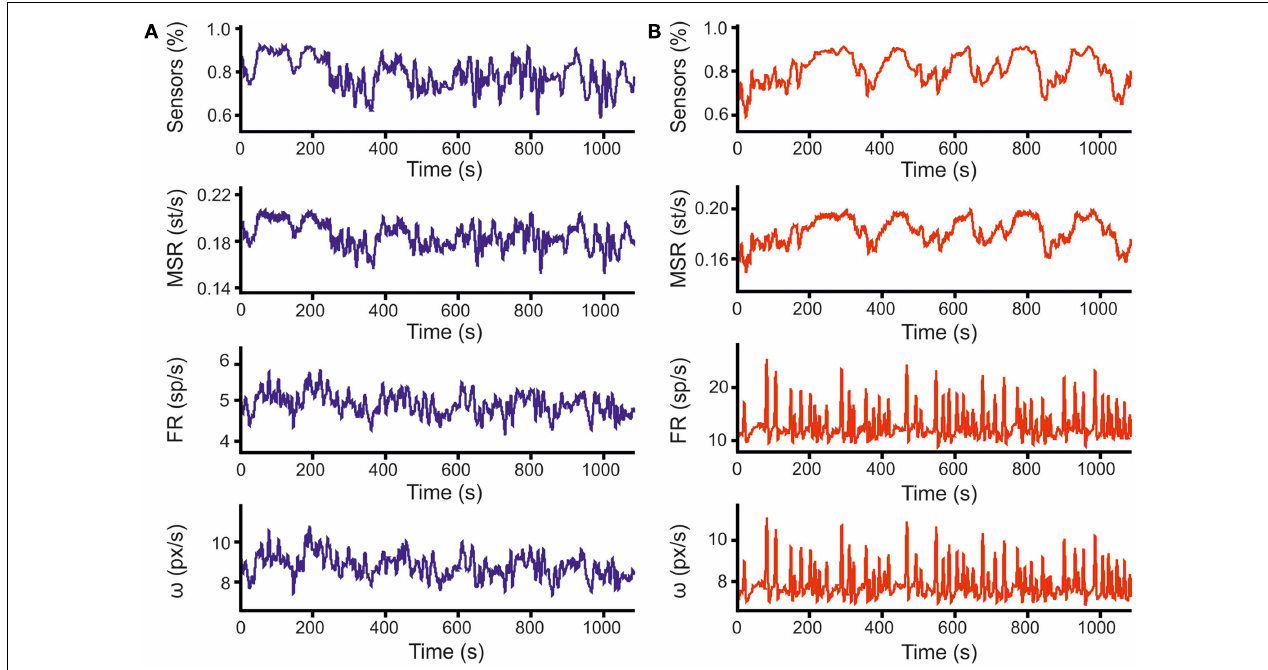
the robot wheels, expressed in pixels per second, as computed according to Eq. 1 from firing rates. Data for stimulation and firing rate are point events at times of delivery (for stimulations) or detection (for spikes), while sensor data and wheel speeds are sampled at 10Hz.The graphs reported above are obtained after low-pass filtering of actual data (sliding Gaussian window over 100 samples – 10s, with an alpha value of 2.5). (B) Same set of graphs as (A) , displaying information for sensors and wheel of the right